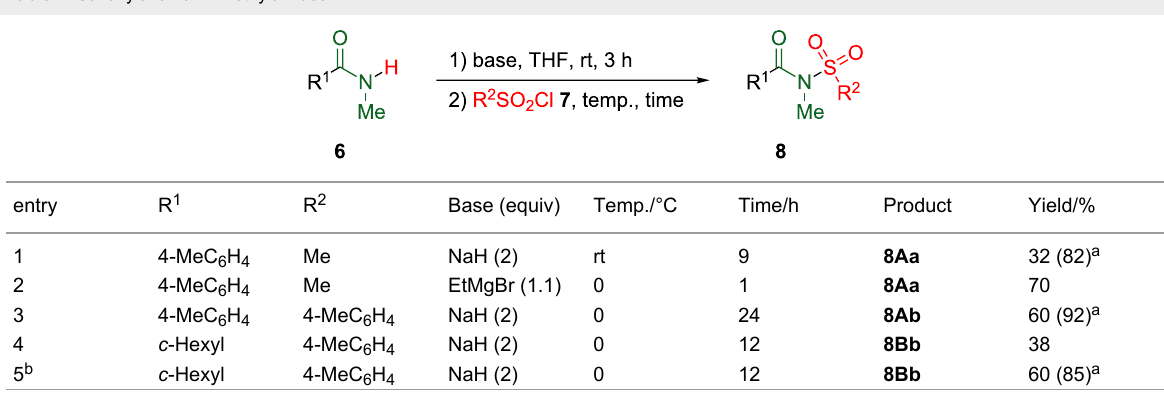
Table 1: Sulfonylation of N